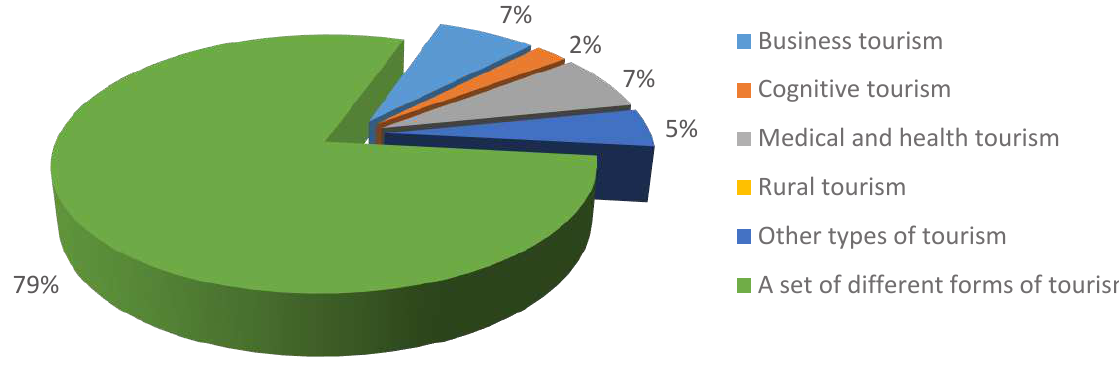
Figure 4. Generalization of experts’ answers within the framework of foresight researh on the priority of Ukraine’s tourism sector development